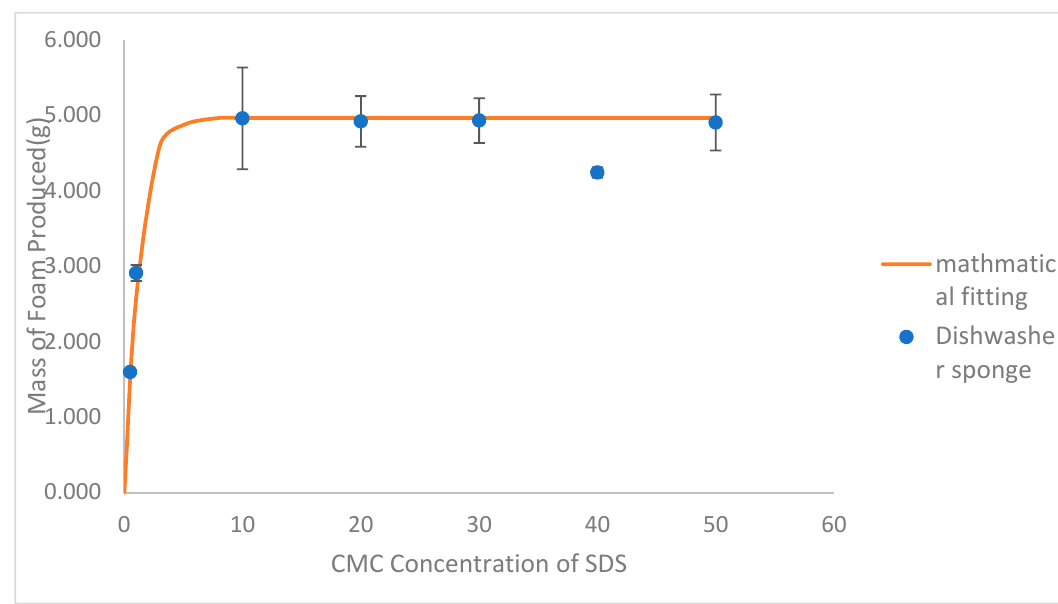
Figure 9. The dependency of surfactant concentration of the mass of foam generated by compression where error bars were determined by the standard deviation for the dishwasher sponge. fitting calculated using Equation (3).